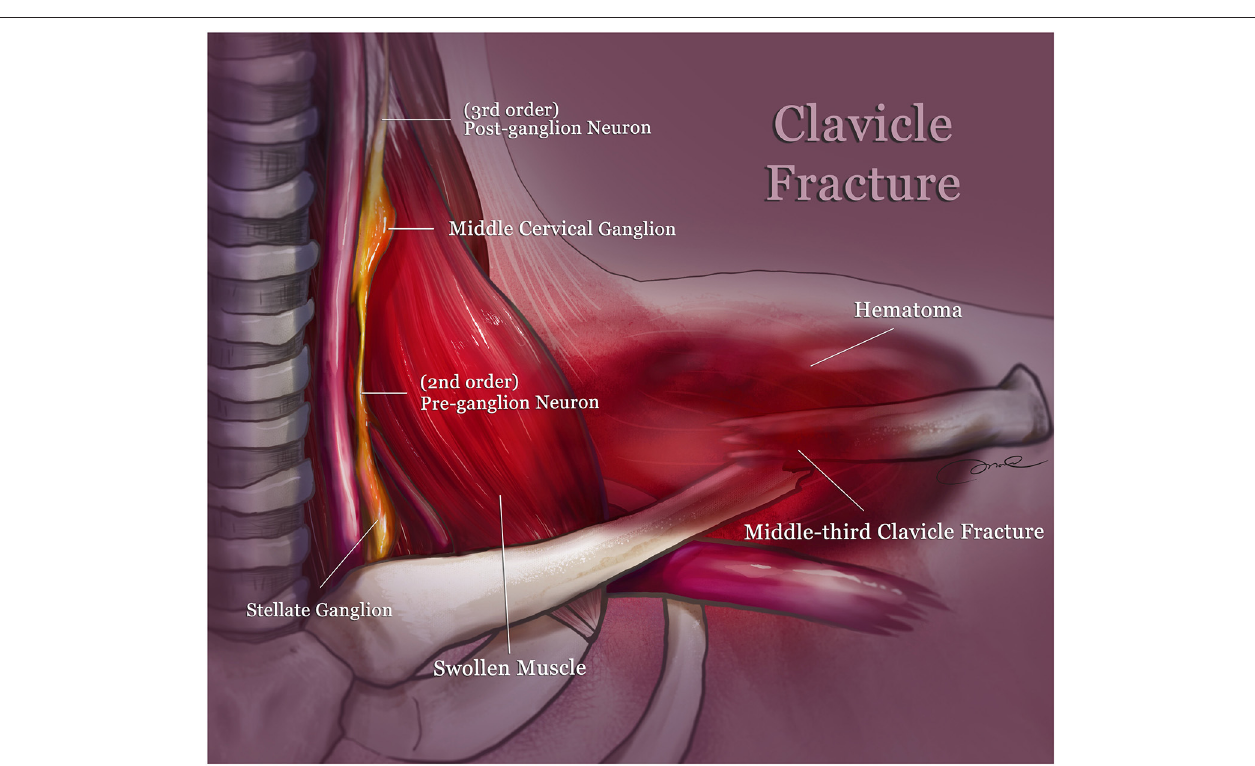
FIGURE 4 | Schematic depicting the injury mechanism: the oculosympathetic pathway may be compressed by the swollen muscle (scalene, sternothyroid muscle) causing a hematoma along the middle-third clavicle fracture. The three neurons involved in this pathway are the first order central neuron (inside the spinal cord, not shown here), second order pre-ganglion neuron (around the thoracic outlet), and third order post-ganglion neuron (near the internal carotid artery).